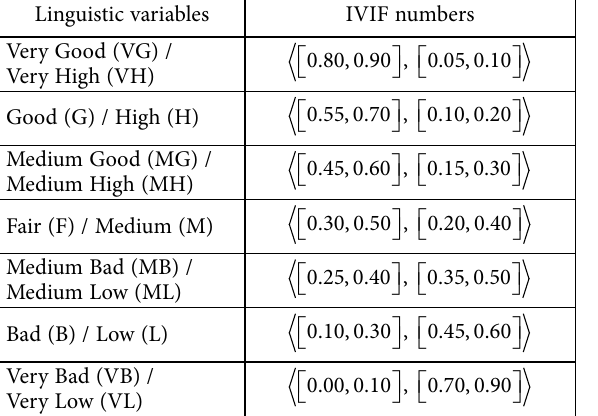
Table 2. Linguistic variables for values of